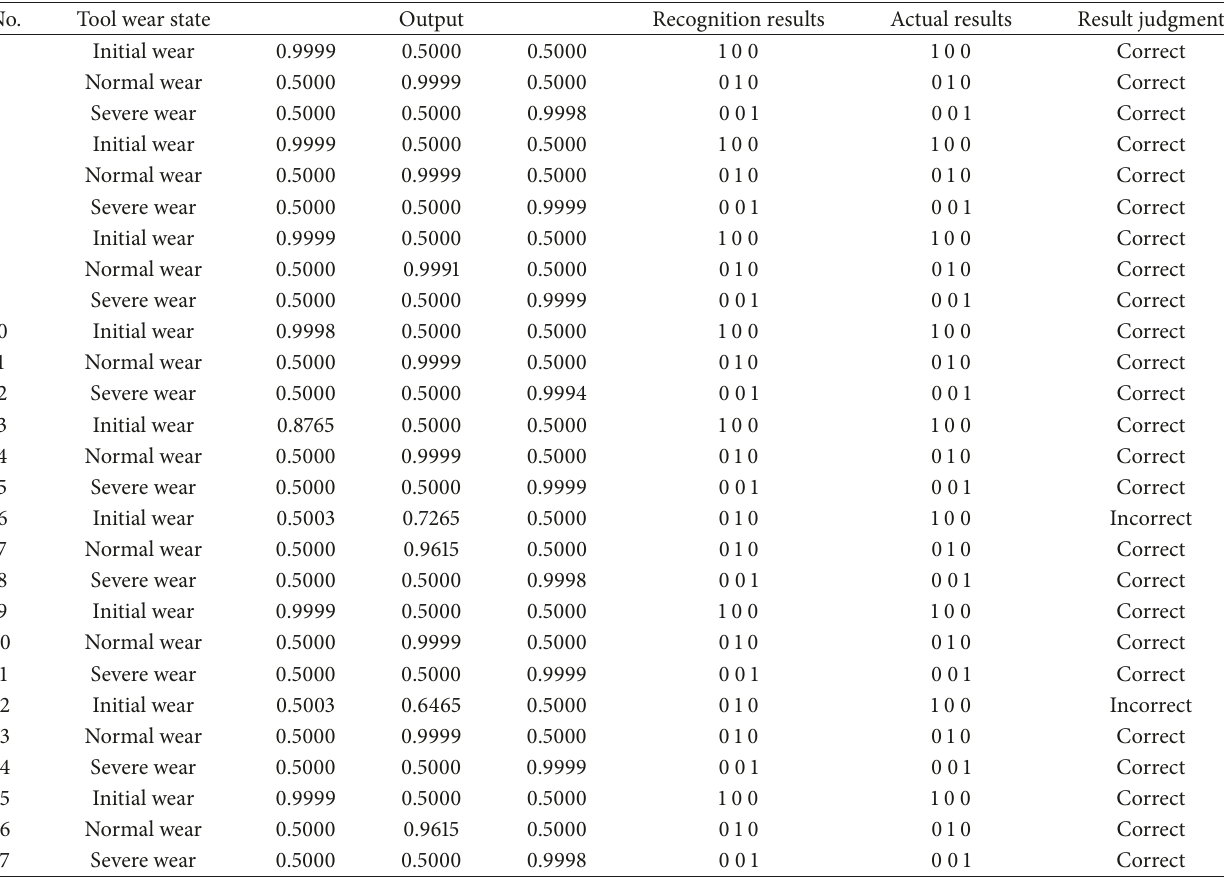
Table 10: Recognition results of cutting tool state.